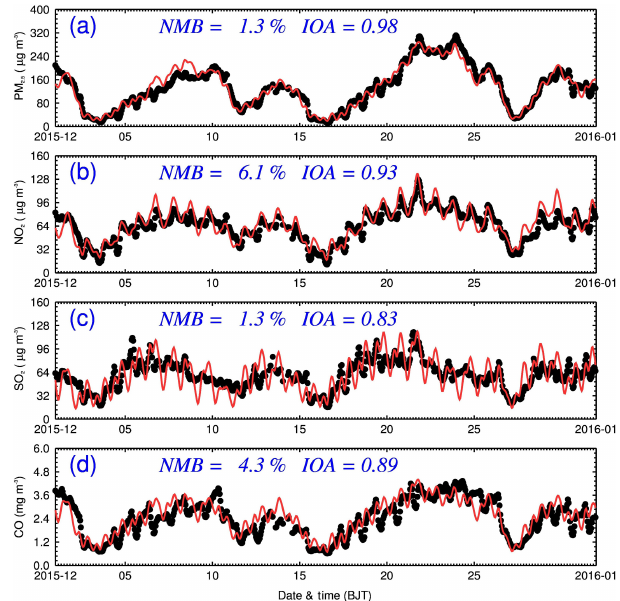
Figure 5. The temporal variations of predicted (red lines) and ob- served (black dots) profiles of near-surface mass concentrations of PM 2 . 5 , NO 2 , SO 2 , and CO averaged over all ambient monitoring sites in the NCP during December